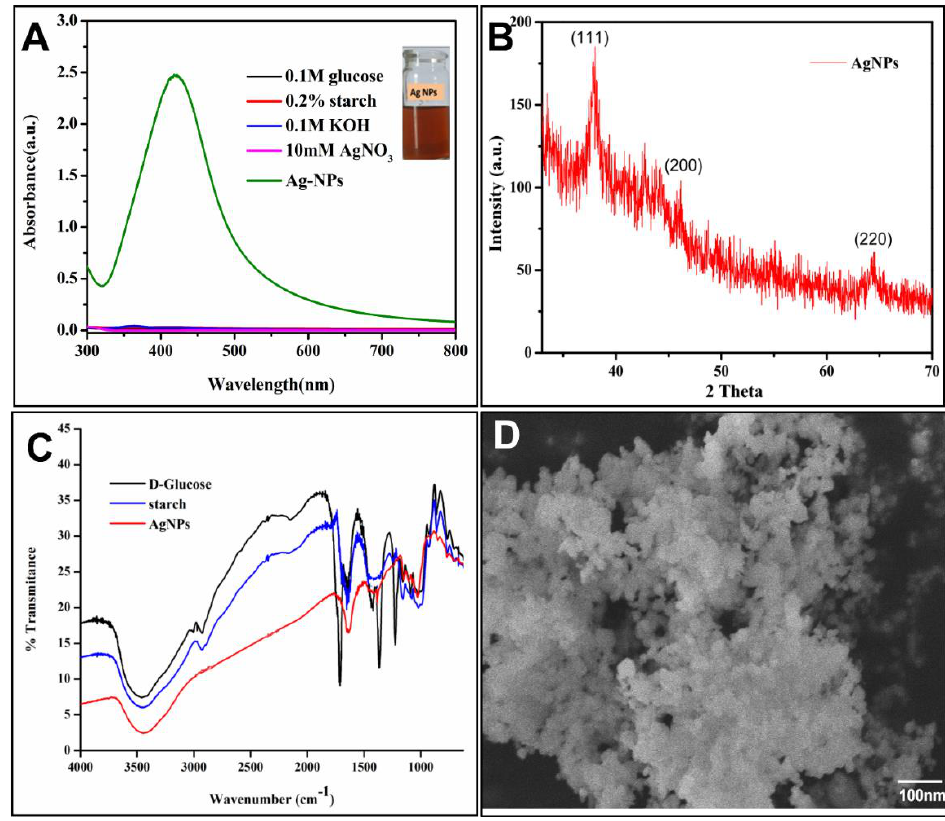
Figure 1. ( A ) UV spectra show Glucose, Starch, KOH, and AgNO 3 and synthesized AgNPs, ( B ) XRD image of synthesized silver nanoparticles. ( C ) FT-IR Spectrum of AgNPs and ( D ) SEM image of synthesized AgNPs.